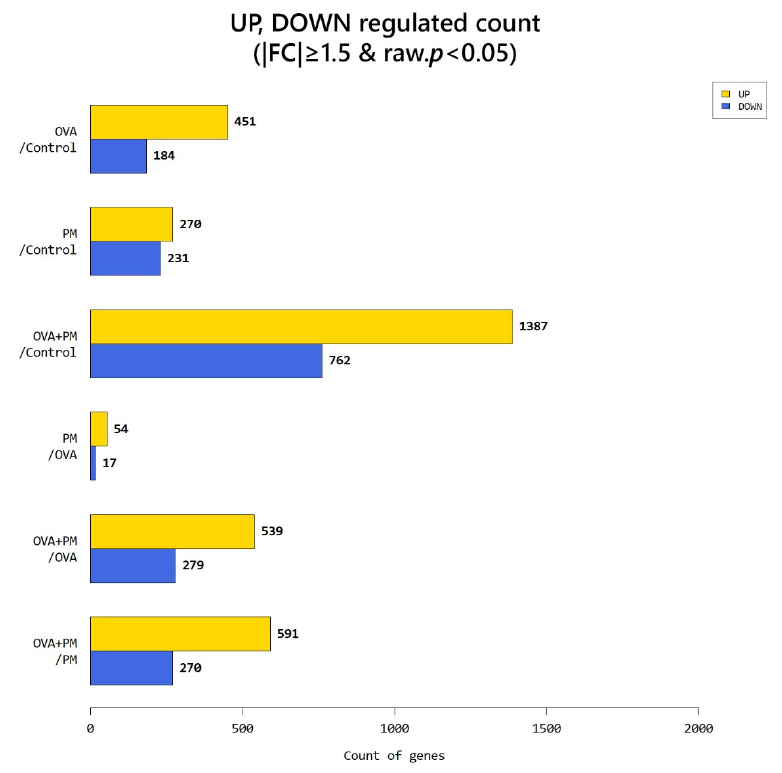
Figure 3. An overview of the differentially expressed genes (DEGs).